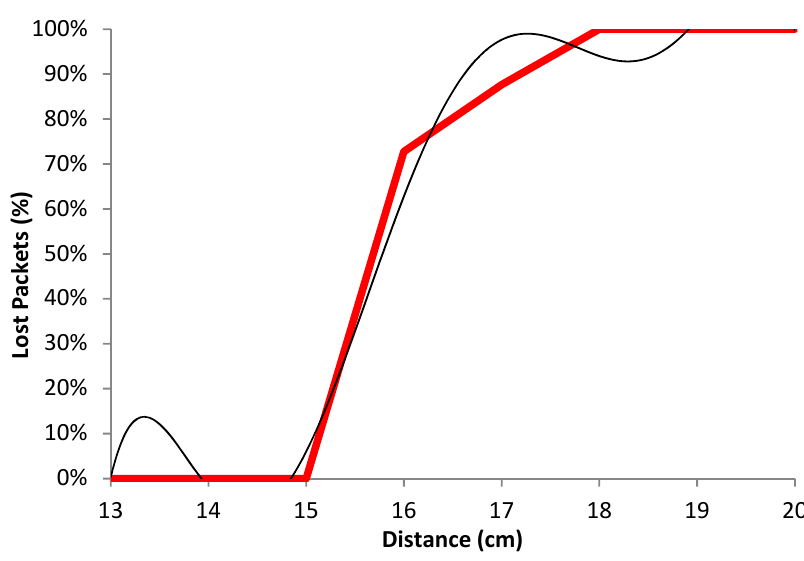
Figure 19. Average lost packets for 5.5 Mbps.